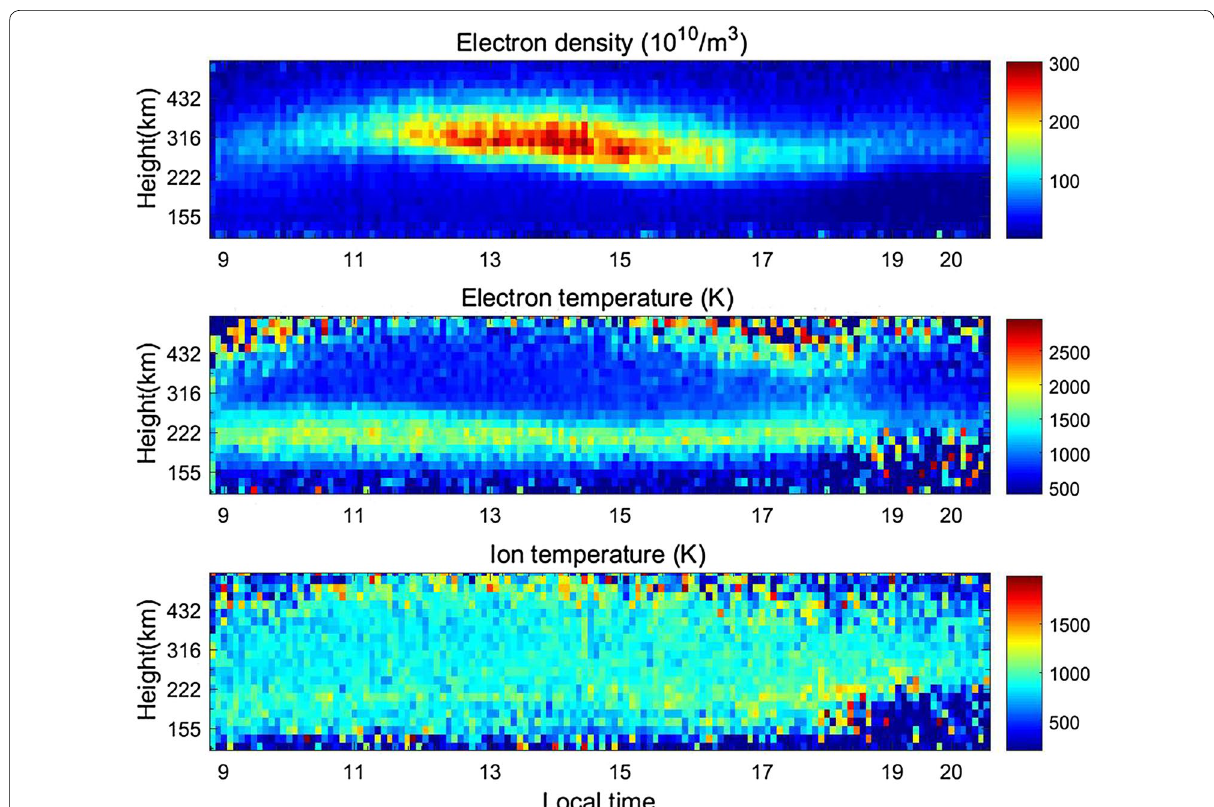
Fig. 13 Temporal variation of ionospheric parameters on May, 2017 (from the top to end: electron density, electron temperature and ion tempera-